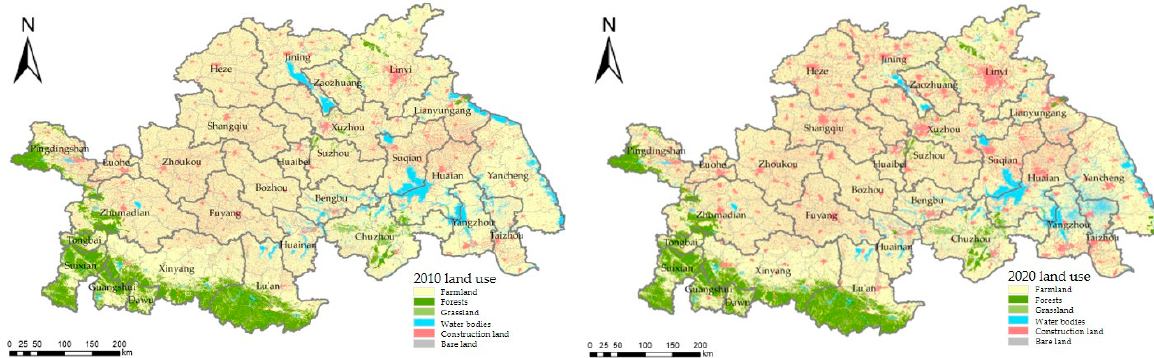
Figure 1. Map of the research area.